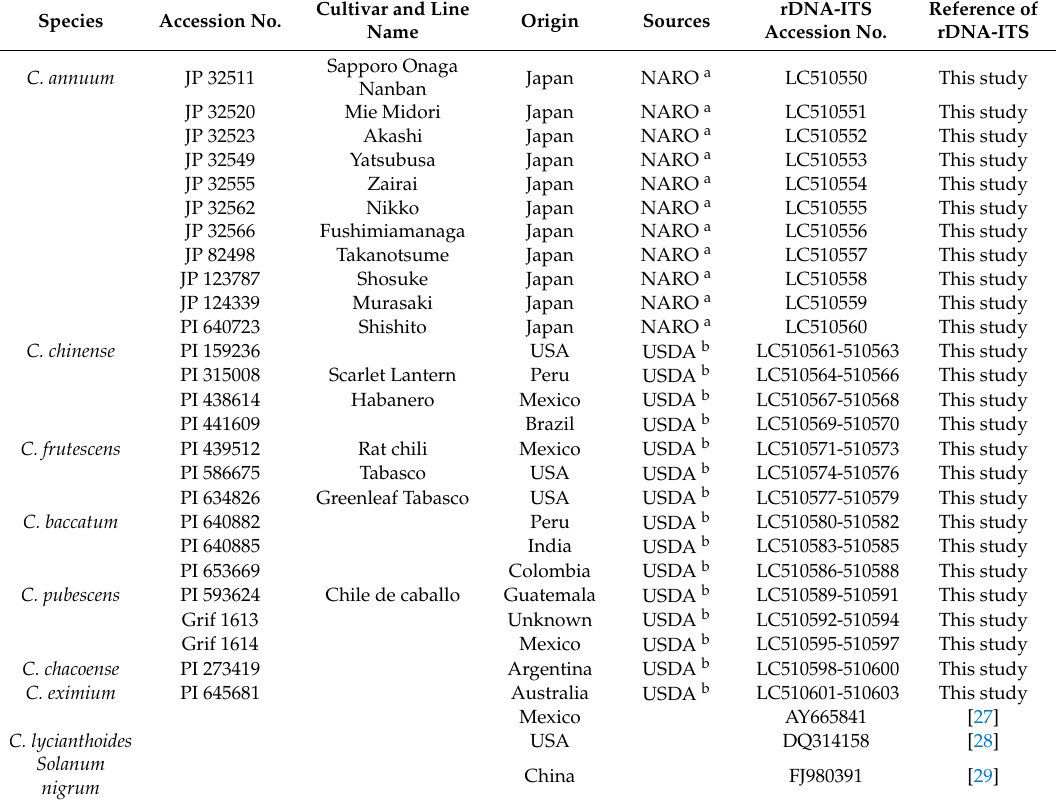
Table 1. Capsicum and rDNA-ITS accessions used in this